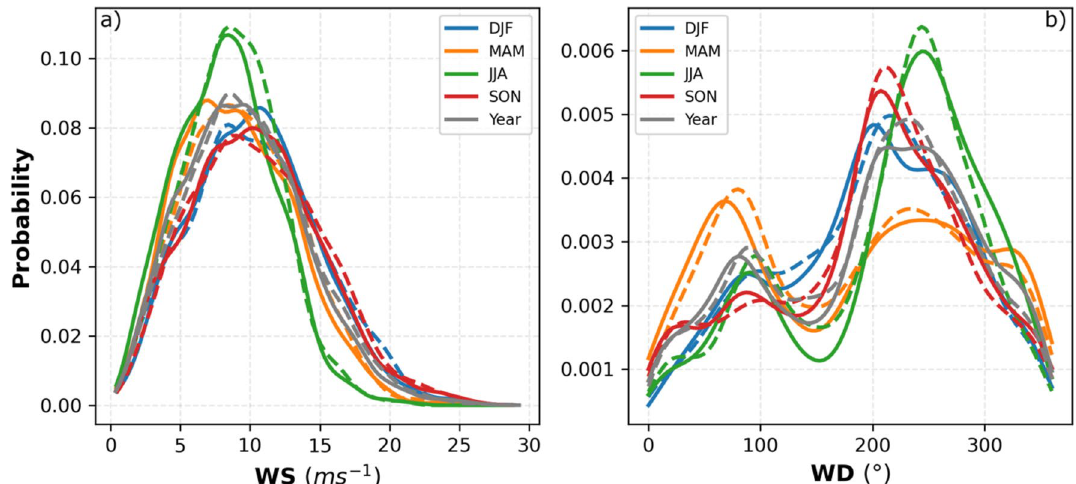
Figure 2. Annual and seasonal probability density functions calculated using the hourly ( a ) wind speed and ( b ) wind direction data at FINO1 (6.5875°E and 54.01472°N) at a height of 90 m in the period 2008–2009. Dashed lines result from measurements, while solid lines are from COSMO-CLM simulation. Gray lines indicate data for the entire period whereas colors indicate the different seasons as given in the